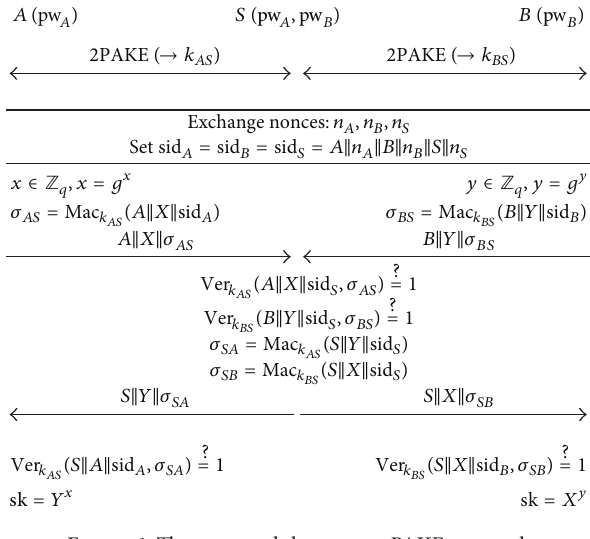
Figure 1: The proposed three-party PAKE